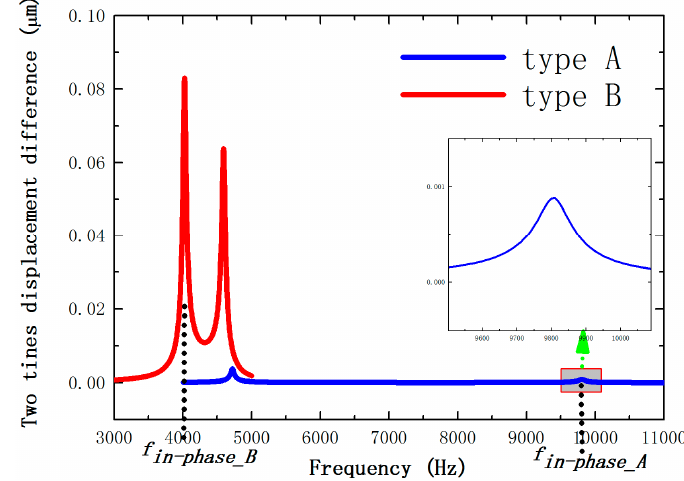
Figure 8. Displacement difference of 1.83% stiffness imbalance TFGs of two types.